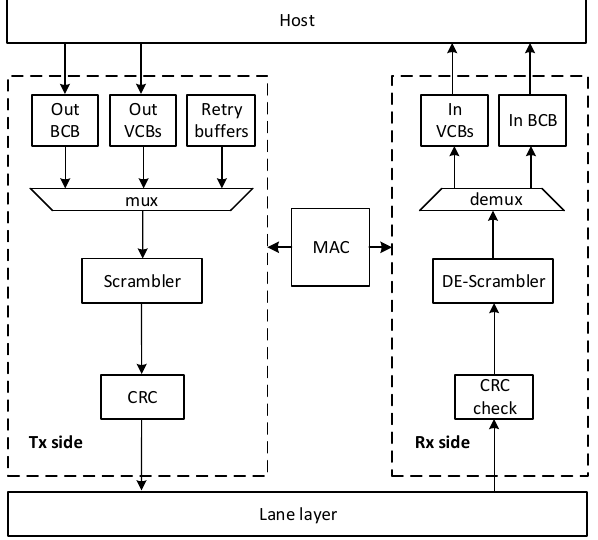
Figure 2. SpaceFibre data link layer block